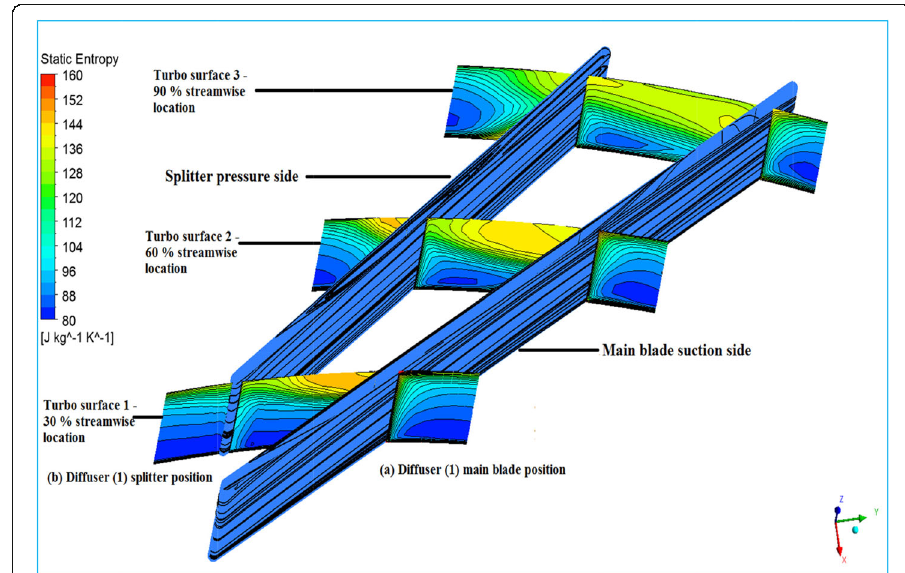
Fig. 14 Entropy distribution at 30, 60, and 90% chord of